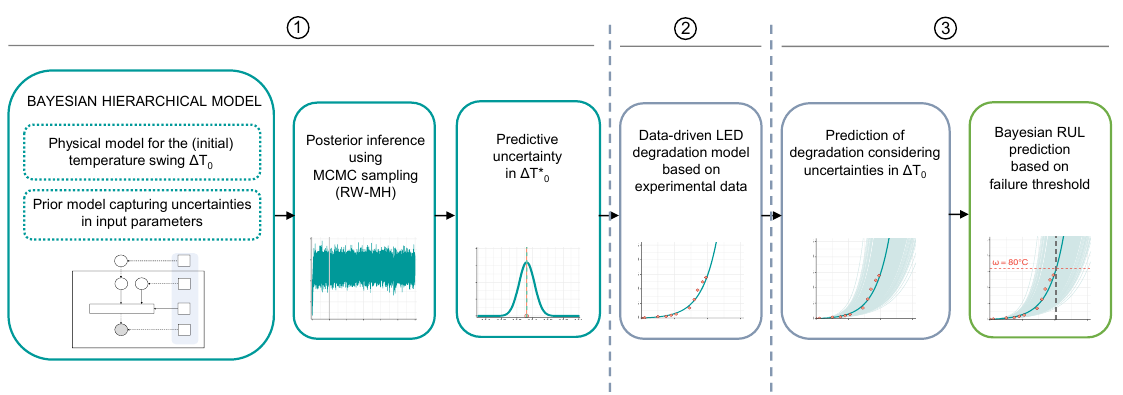
Figure 3. Workflow: (1) BHM framework (Section 3.2), (2) data-driven model for LED degrada- tion [43], (3) impact of uncertainty in ∆ T 0 on RUL prediction (Section